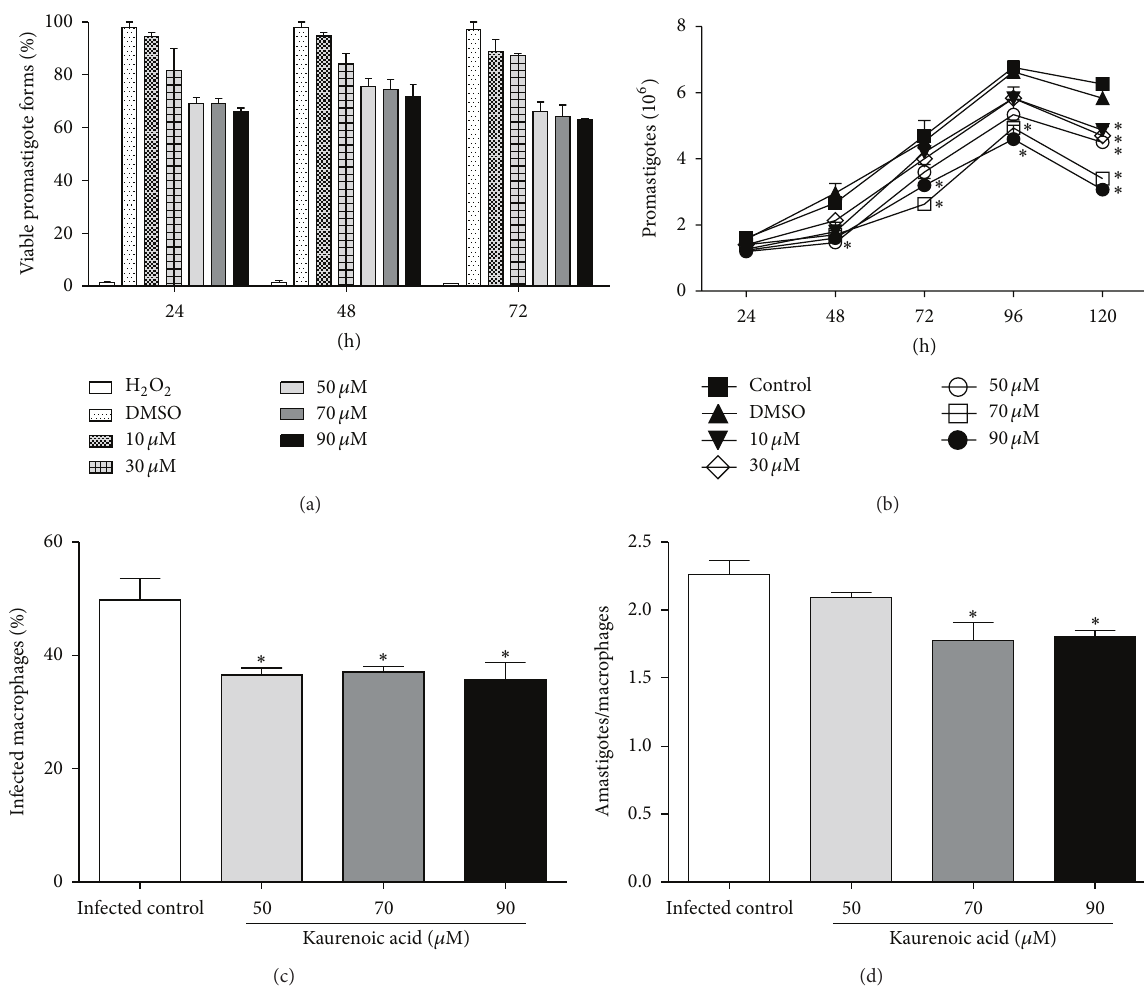
Figure 1: Kaurenoic acid has a leishmanicidal effect against promastigote and amastigote forms of L. amazonensis . MTT assay in promastigote forms of L. amazonensis treated with kaurenoic acid (10, 30, 50, 70, and 90 𝜇 M) or 0.2% DMSO for 24, 48, and 72 h (Panel (a)). Proliferation kinetics of L. amazonensis promastigote forms after pretreatment for 24 h with kaurenoic acid (10, 30, 50, 70, and 90 𝜇 M) or 0.2% DMSO for 24, 48, 72, and 120h (Panel (b)). Percentage of infected macrophages (Panel (c)) and number of amastigotes per macrophage after 24 h of incubation with kaurenoic acid (50, 70, and 90 𝜇 M) (Panel (d)). Data represent mean ± SEM of three independent experiments (promastigotes) and six independent experiments (amastigotes). ( ∗ Significantly different from control ( 𝑃 < 0.05 compared with control group promastigotes in culture medium) (one-way ANOVA followed by Tukey’s test).)